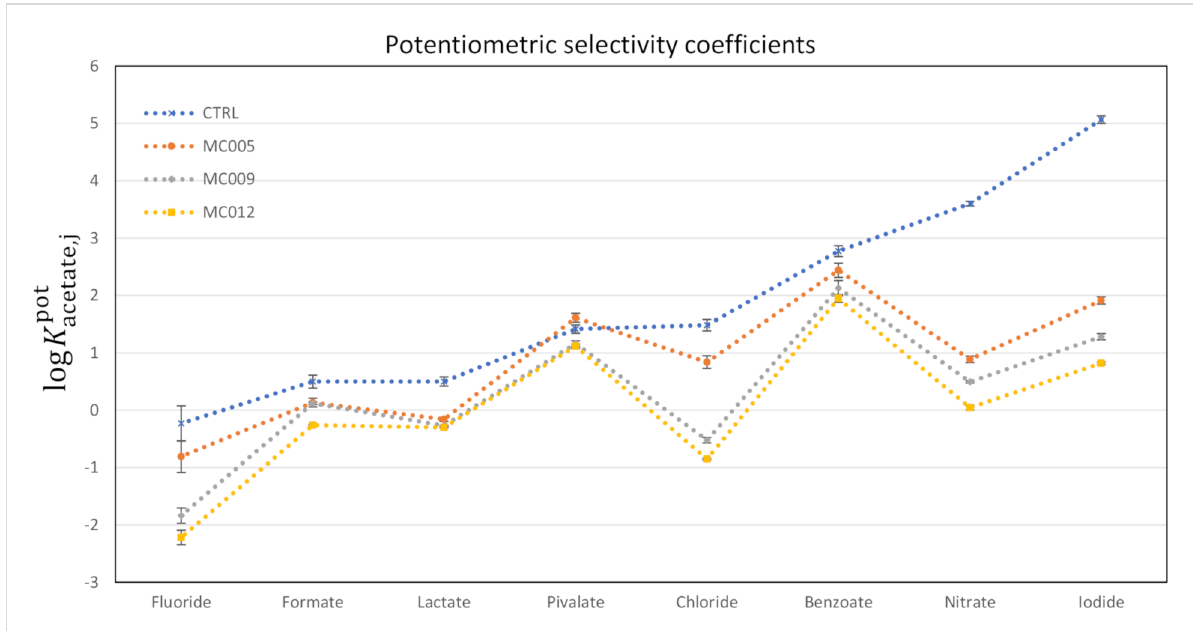
Figure 10: Potentiometric selectivity coefficients of interfering anions (relative to acetate) determined using the separate solution method at ambient temperatures. All anions were used as sodium salts. The uncertainties (error bars) express standard deviations.